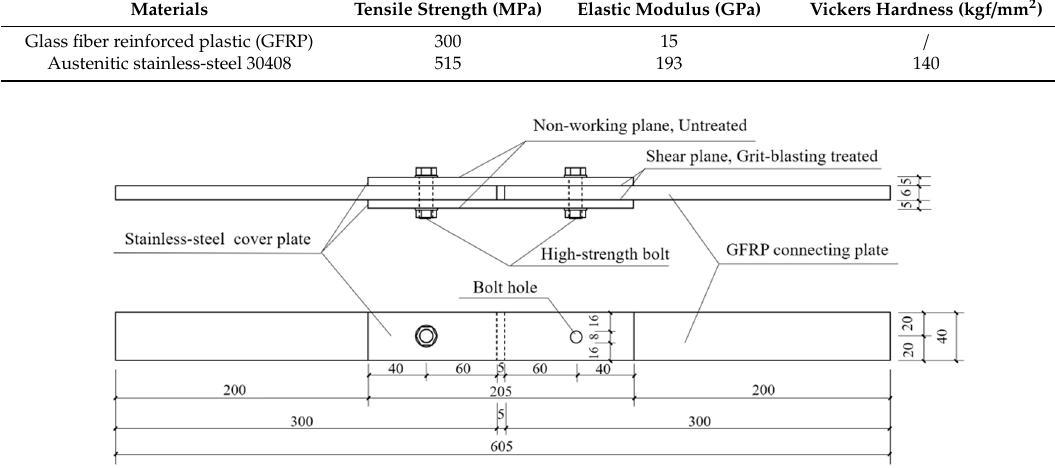
Figure 1. Specimen size (unit:mm).